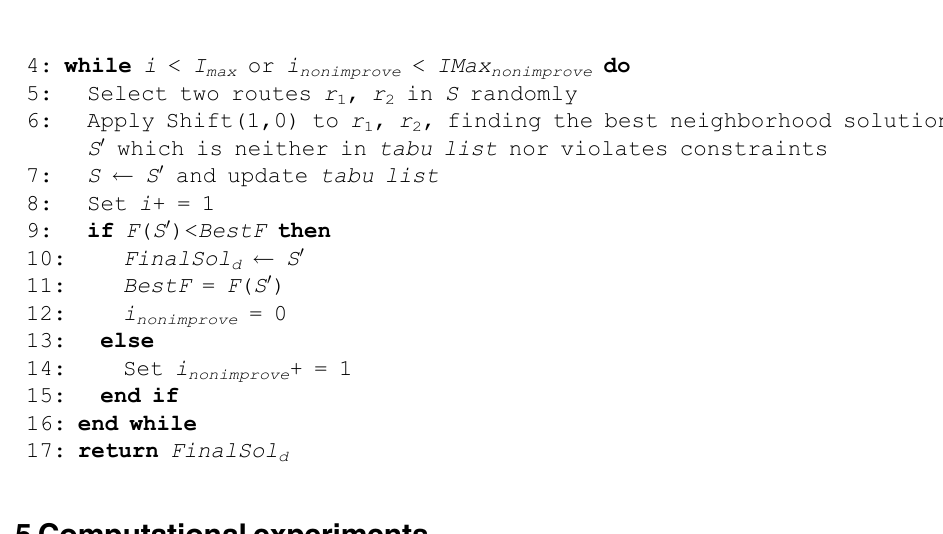
} is the maximum distance j